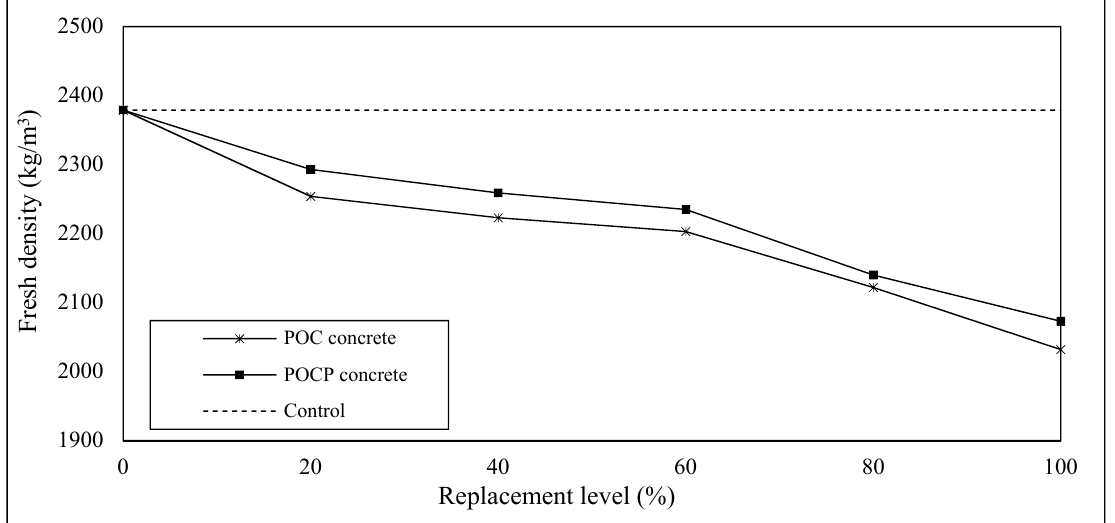
Figure 10. Fresh density of POCP concrete and POC concrete.